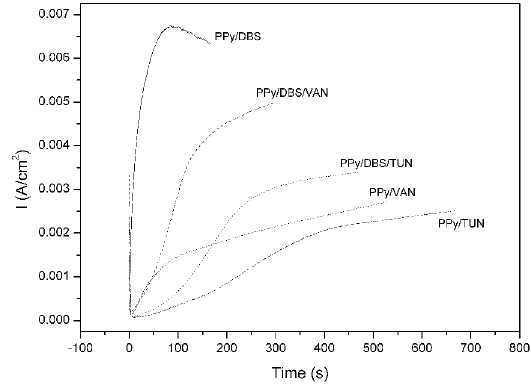
Figure 1. I-t transients obtained for the electrosynthesis of PPy on AA 1100 at 1.0 V in 0.4 mol L -1 pyrrole with: 0.05 mol L -1 Na (PPy/ VAN); 0.05 mol L -1 Na (PPy/DBS) and 0.05 mol L -1 Na